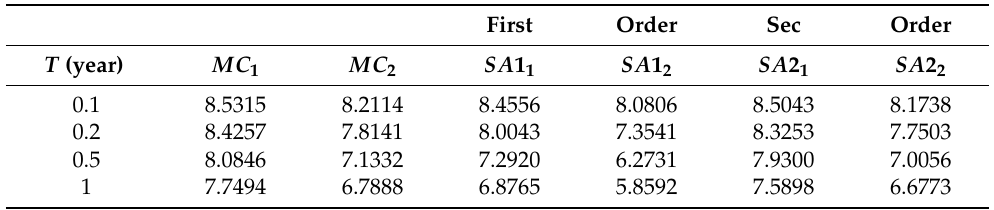
Table 1. Call option prices (N = 2).